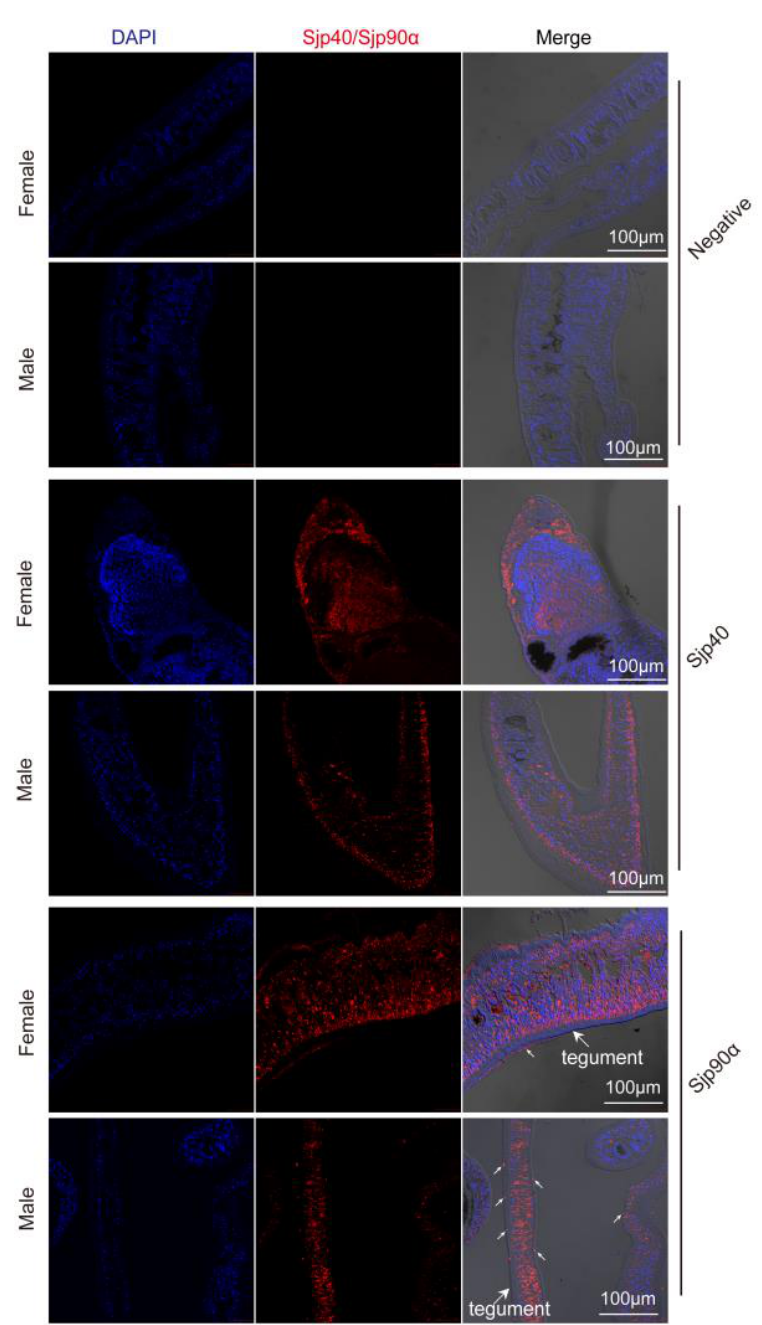
Figure 4. Distribution of Sjp40 and Sjp90α in adult S. japonicum. Immunolocalization of Sjp40 and Sjp90α in the worms of S. japonicum. Adult male and female worm sections were labelled with mouse anti-rSjp40 and anti-rSjp90α antibody coupled with Alexa-Fluor 647 goat anti-mouse IgG (red), DAPI was used to stain for nuclei and the samples were analyzed using a Zeiss 780 NLO laser. Negative control sections of the worm were incubated with normal mouse serum. Scale-bars: 100 μm. White arrows indicate the Sjp90α expressed in the tegument of worms. 2.5. Effect of rSjp40 and rSjp90α on Hepatic Immune Cells